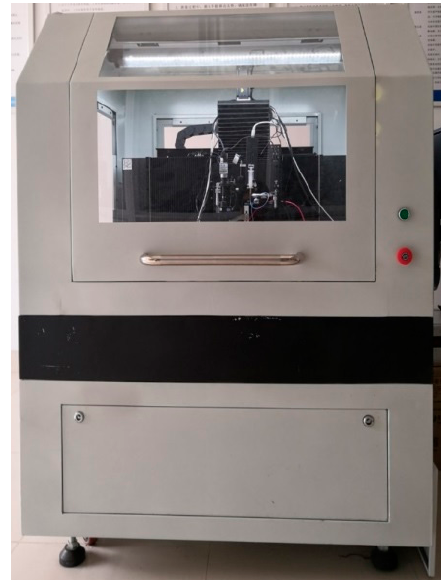
Figure 3. The self-developed experimental setup of the NFEDW method.